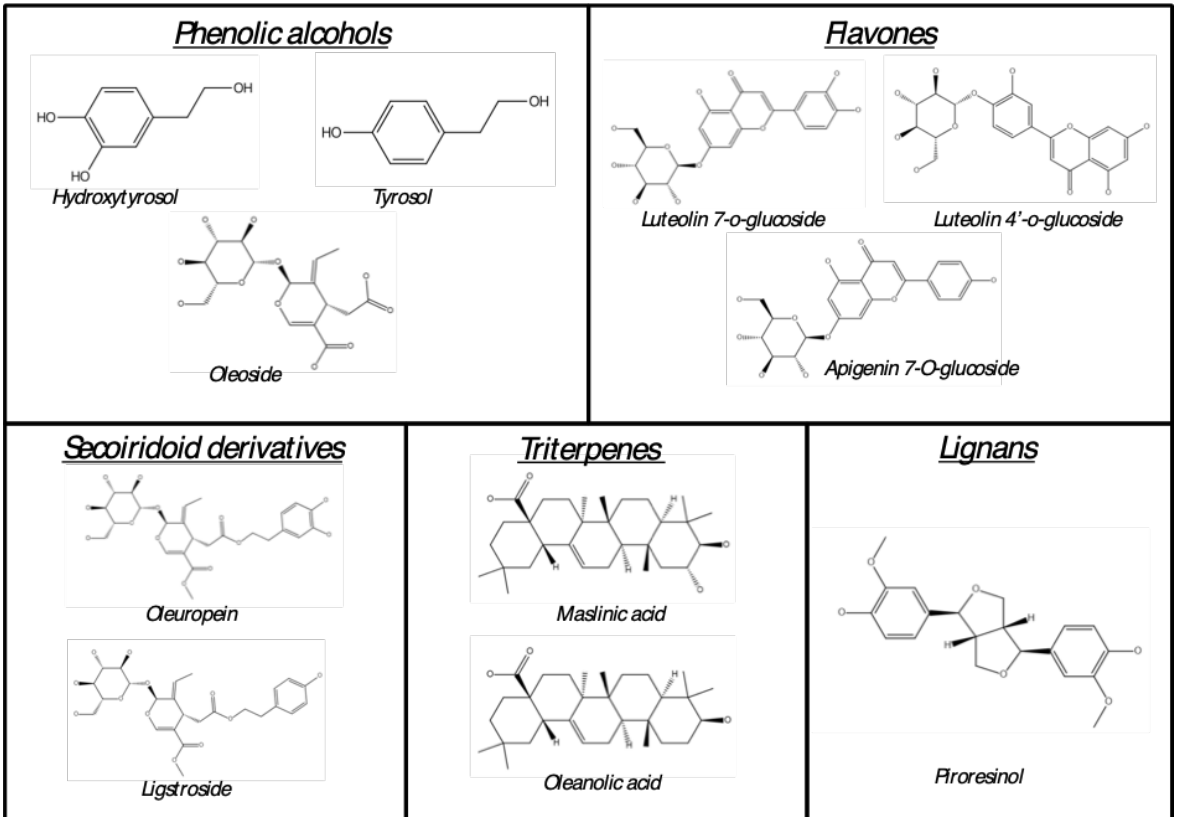
Figure 1. Most representative phytochemical compounds in OL.